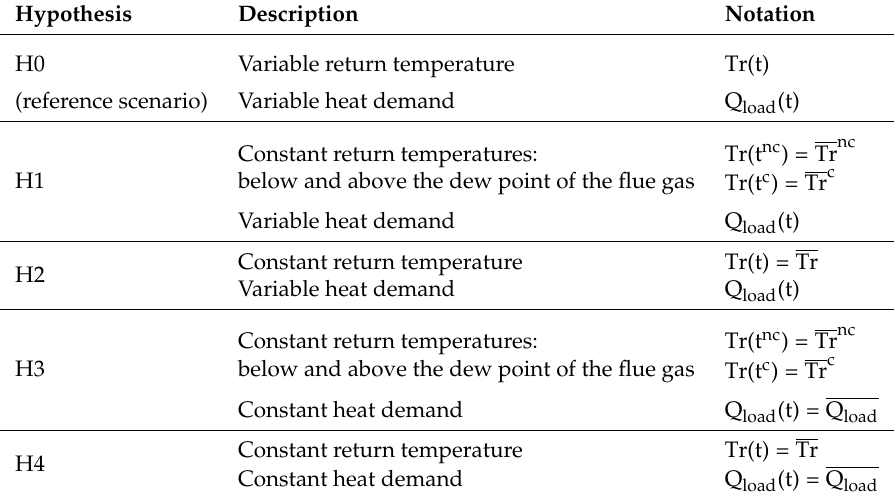
Table 4. A summary of the hypothesis used in the additional cases investigated to highlight the impact of the usual assumptions on the energetic and economic